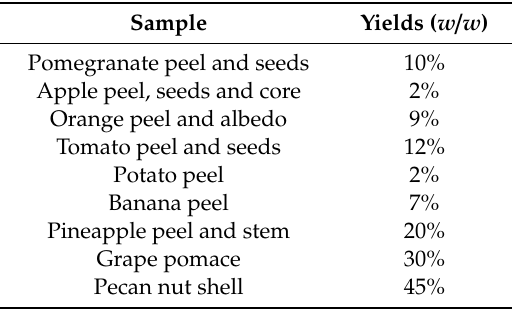
Table 2. Recovery yields of hydrolyzed waste materials.